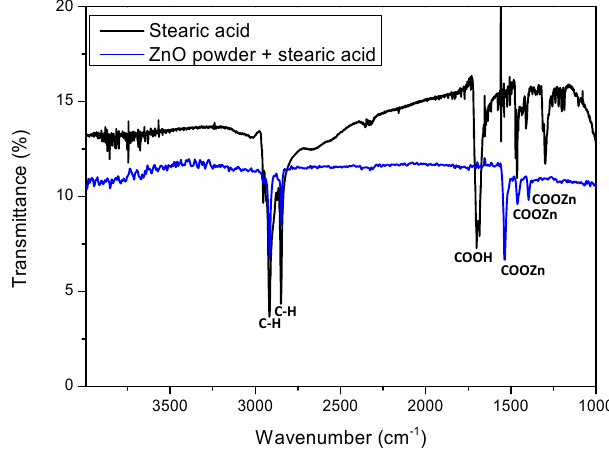
Figure 1. Attenuated total reflectance (ATR) spectra of stearic acid (black trace) and zinc oxide (ZnO) powder after treatment with stearic acid (blue trace).